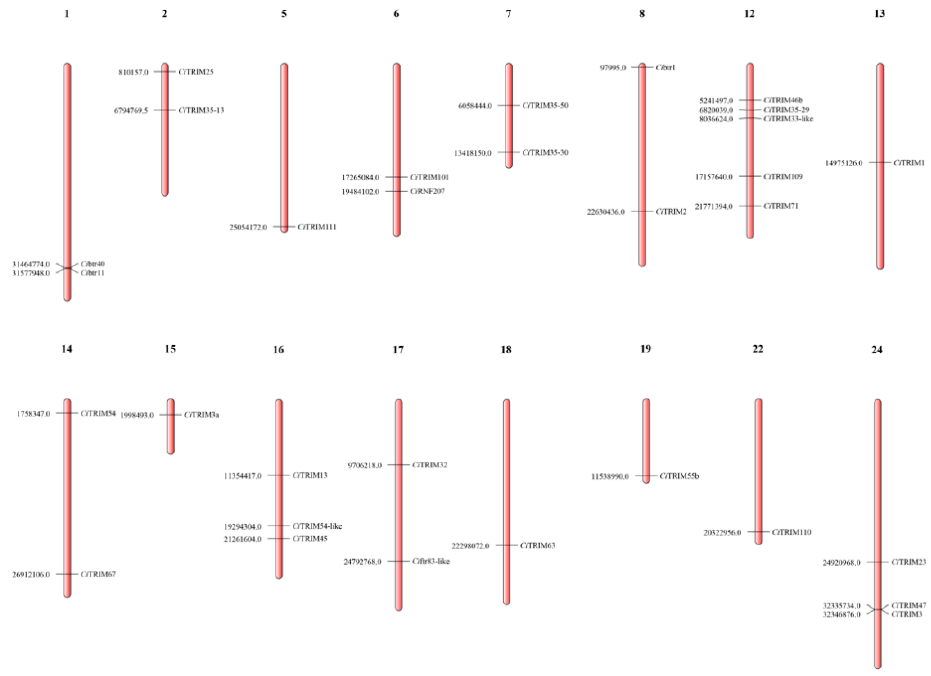
Figure 2. Chromosomal locations of Ci TRIMs. The number on the left represents the position of the Ci TRIM gene on the chromosome .